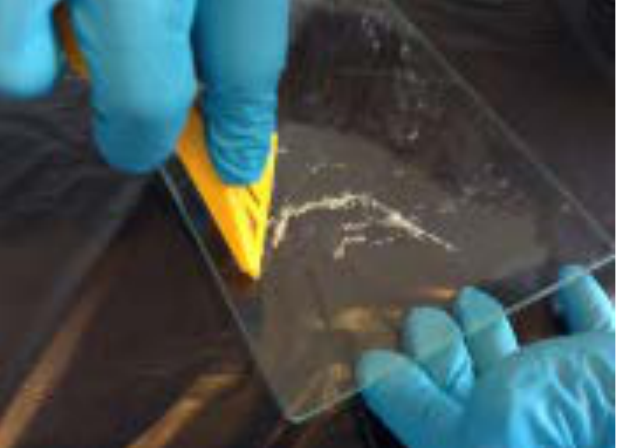
Figure 5. Scrape of the Vespa velutina venom obtained from a colony of 960 individuals from a captive nest last November 2020.